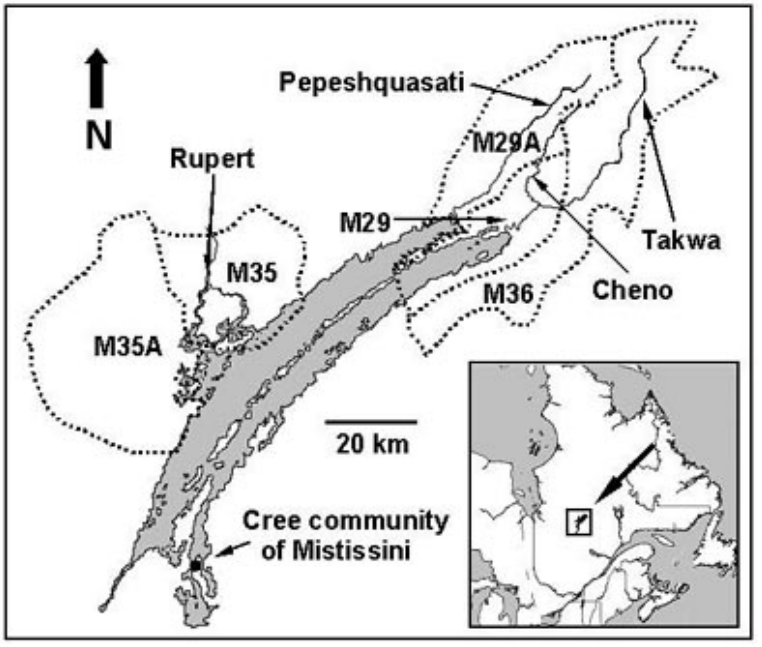
Fig. 1. Geographic location of Mistassini Lake, Quebec in eastern North America, connecting rivers used as breeding grounds by migratory brook charr ( Salvelinus fontinalis ) in the lake, as well as the locations and family trapline designations of traditional hunting and fishing territories of informants interviewed in the study. Trapline designations follow those used by the local community of Mistissini, Quebec. To respect confidenciality of observations shared by individual informants, we have elected not to associate individual informant numbers (see Tables 3—5) with particular